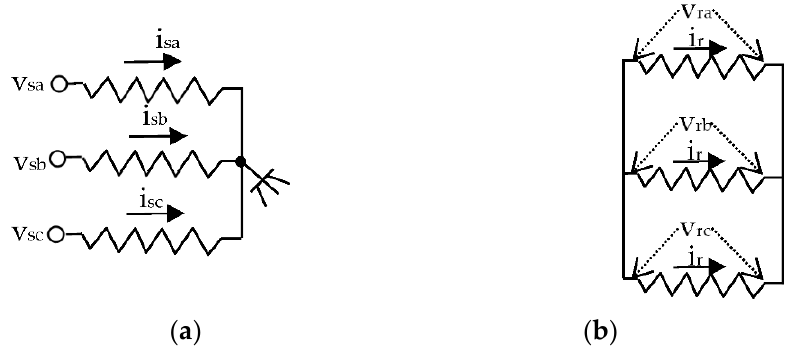
Figure 9. Equivalent electrical circuits for ( a ) stator and ( b ) rotor windings.